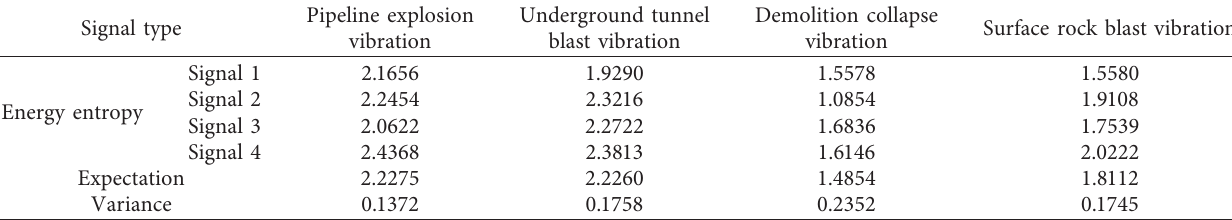
Table 1: Comparison of energy entropy of typical vibration signals.